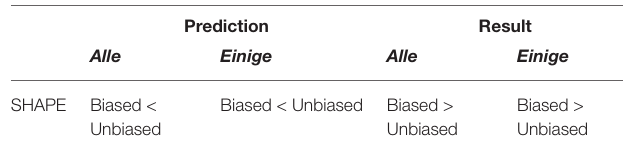
TABLE 2 | Summary of the